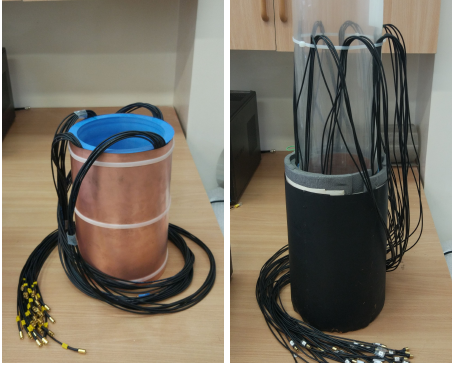
Figure 4. Pictures of two experimental constructions of 3D ECT sensors under